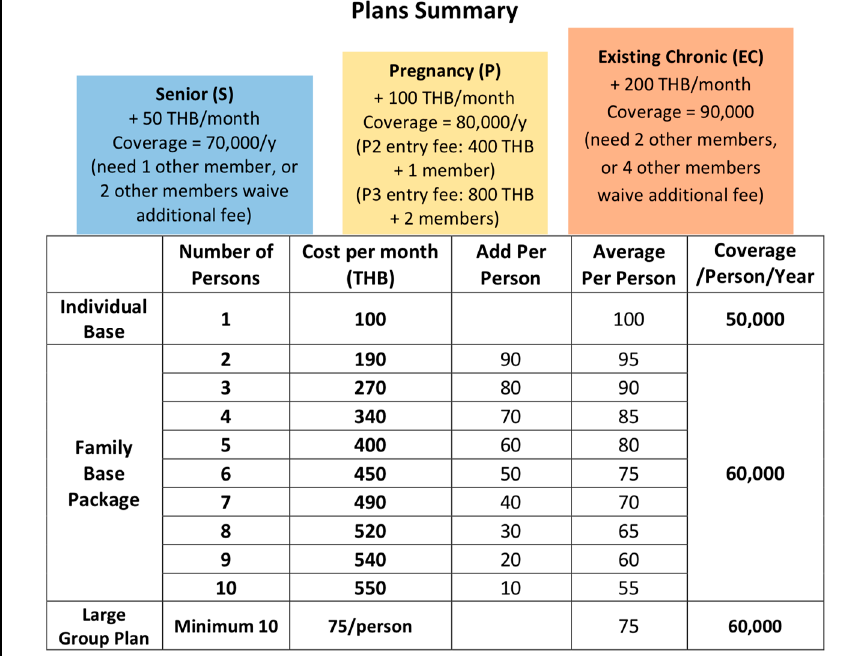
Figure 1. Summary of medical plans offered in the M-Fund Policy 2.0 (Source: M-Fund Policy 2.0, Dreamlopments).